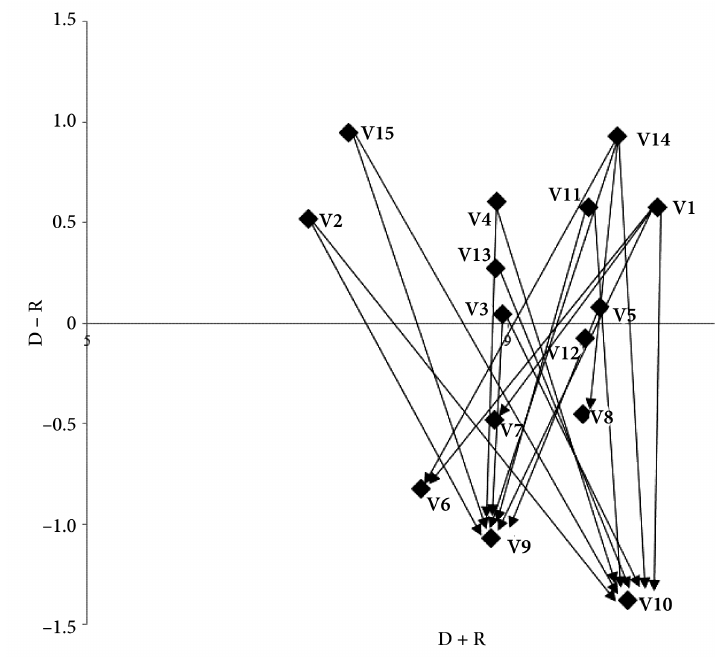
Figure 2. Causal relation